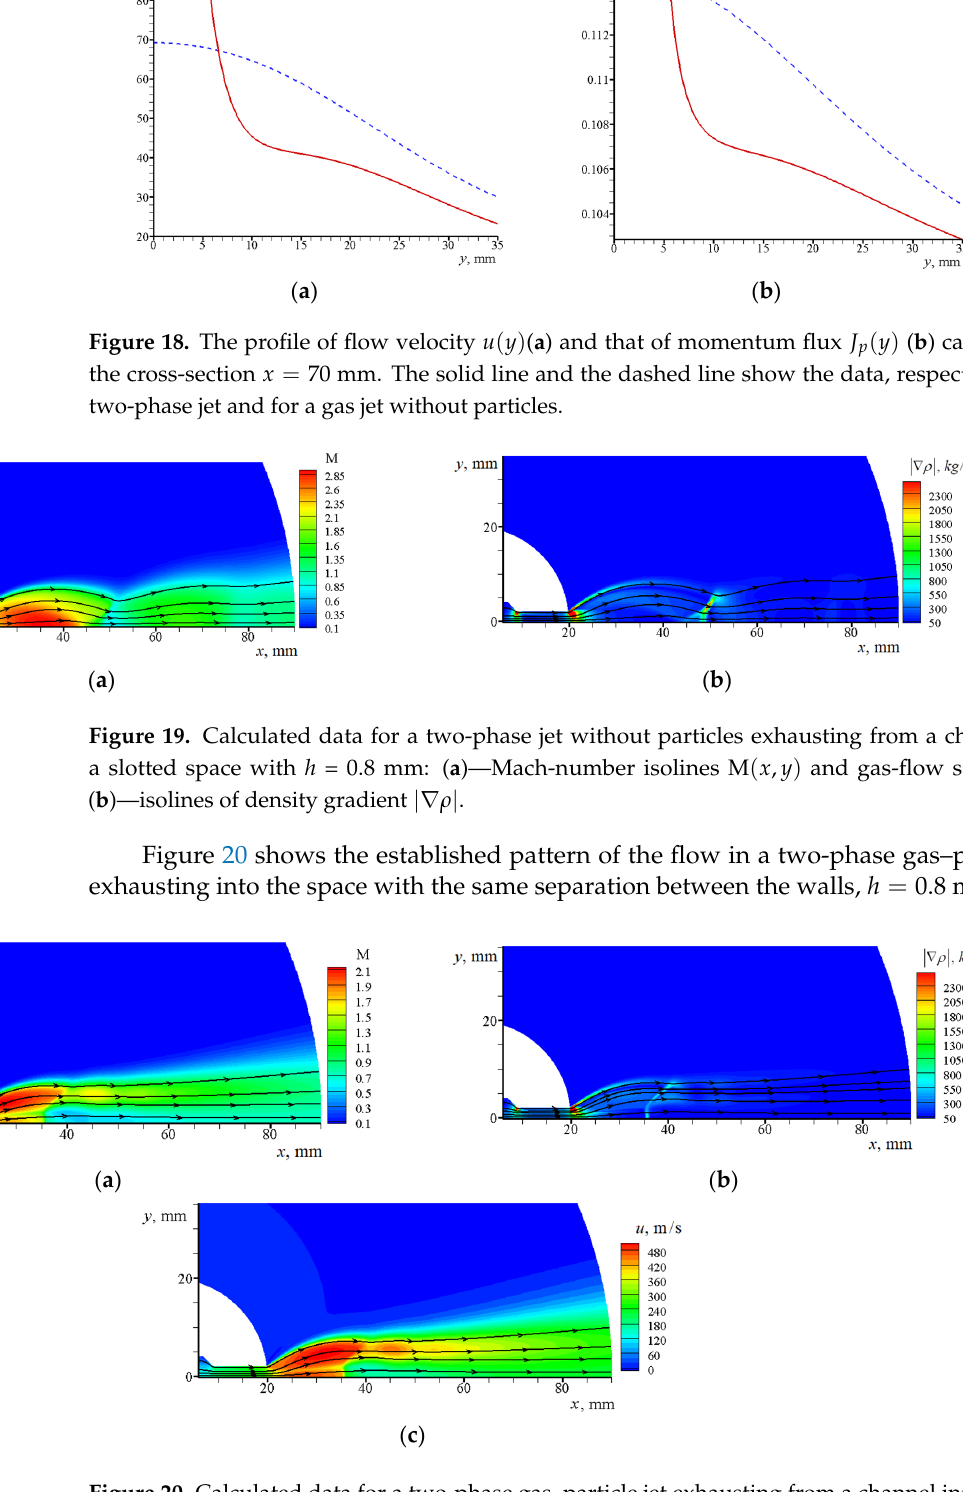
Figure 20. Calculated data for a two-phase gas–particle jet exhausting from a channel into a slotted space with h = 0.8 mm: ( a )—Mach-number isolines M ( x , y ) and gas-flow streamlines; ( b )—isolines of density gradient |∇ ρ | ; ( c )—longitudinal gas velocity u ( x , y ) and gas-flow From Figure 20, it is seen that the structure of the two ‐ phase gas–particle jet consid ‐ erably differs from the structure of the gas jet without particles. The jet exhausting from the channel is accelerated to a supersonic velocity and also splits into two jets. The first (internal) jet is located in the particle region, while the external jet moves in the region over the particle jet. In this case, no barrels that arise when an underexpanded jet exhausts into a submerged space are observed in the gas flow (see Figure 19). At , in the flow there arises a curvilinear shock wave, which consists of two characteristic sec ‐ tions. In the region of the internal jet, the shock is normal; therefore, the flow behind this shock is subsonic. In the region of the second (external) jet, the shock wave is oblique, and the flow behind the latter jet therefore remains supersonic. Since, in the latter case, no deceleration of the external jet occurs, the velocity of this jet exceeds the velocity of the internal jet (see Figure 21a). Figure 21 shows the distribution of gas velocity and momen ‐ tum flux across the flow for a two ‐ phase jet and in a gas jet without particles.